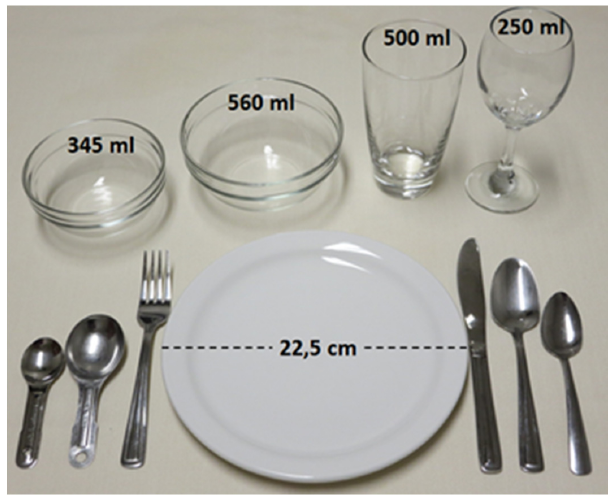
Figure 1. Dishes set used for the portion size photographs.